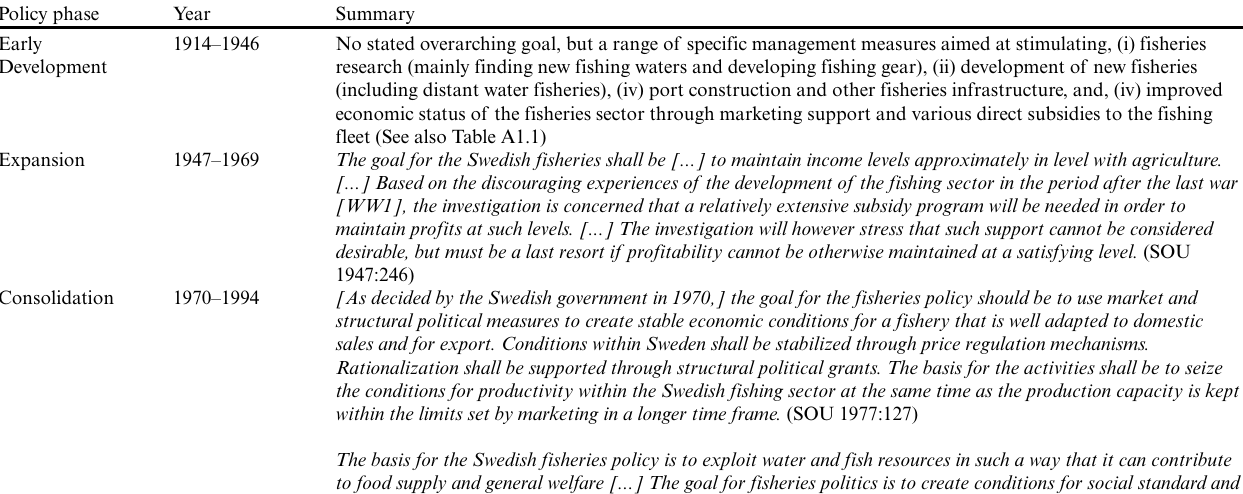
Table 1 . Goals of the Swedish fisheries policy 1914–1995, and goals for the EU Common Fisheries Policy (CFP) added for reference. Original quotes in Swedish were translated by the article